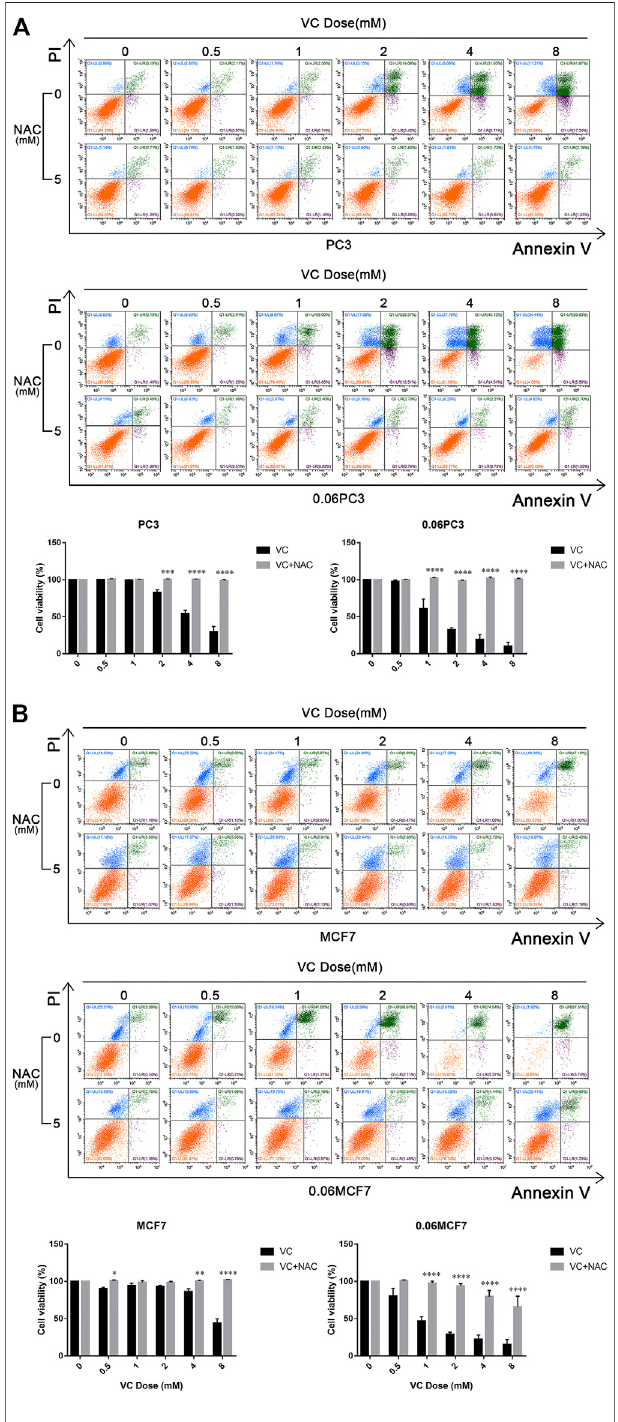
FIGURE 5 | The cytotoxicity of VC reversed by NAC. Cell apoptosis evaluated by annexin-V/PI assay after treatment with VC(4 mM), NAC(5 mM), VC(4 mM) + NAC(5 mM) for indicated times. A and B. Pretreatment with 5 mM NAC for 1 h signi fi cantly prevented the cytotoxic effect induced by VC treatment. All data are presented as means ± SEM, * p < 0.05, ** p < 0.01, *** p < 0.001, **** p < 0.0001, n (cid:2) 3. VC, Vitamin C; NAC,